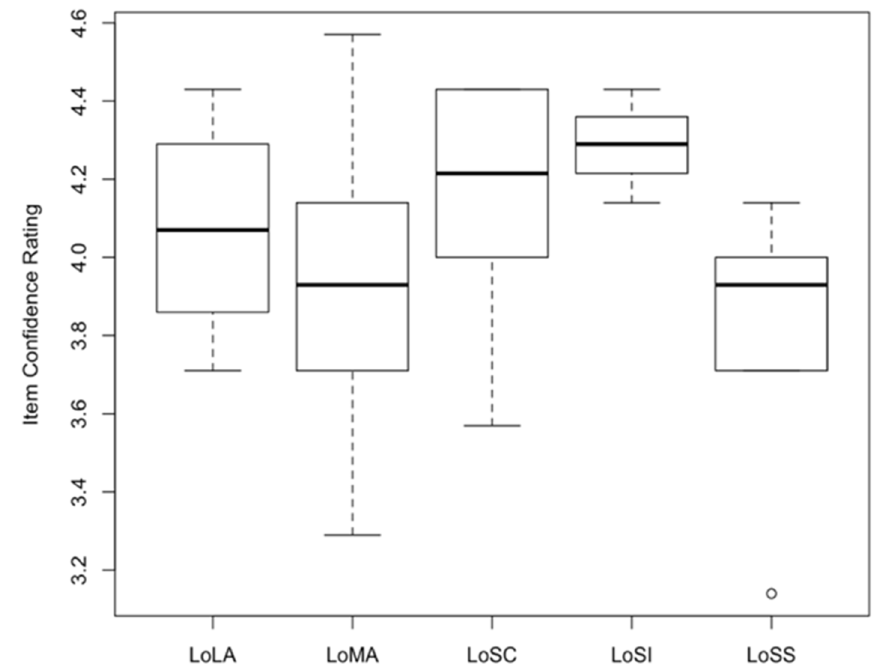
Fig. 2 Distribution of confidence ratings across content areas